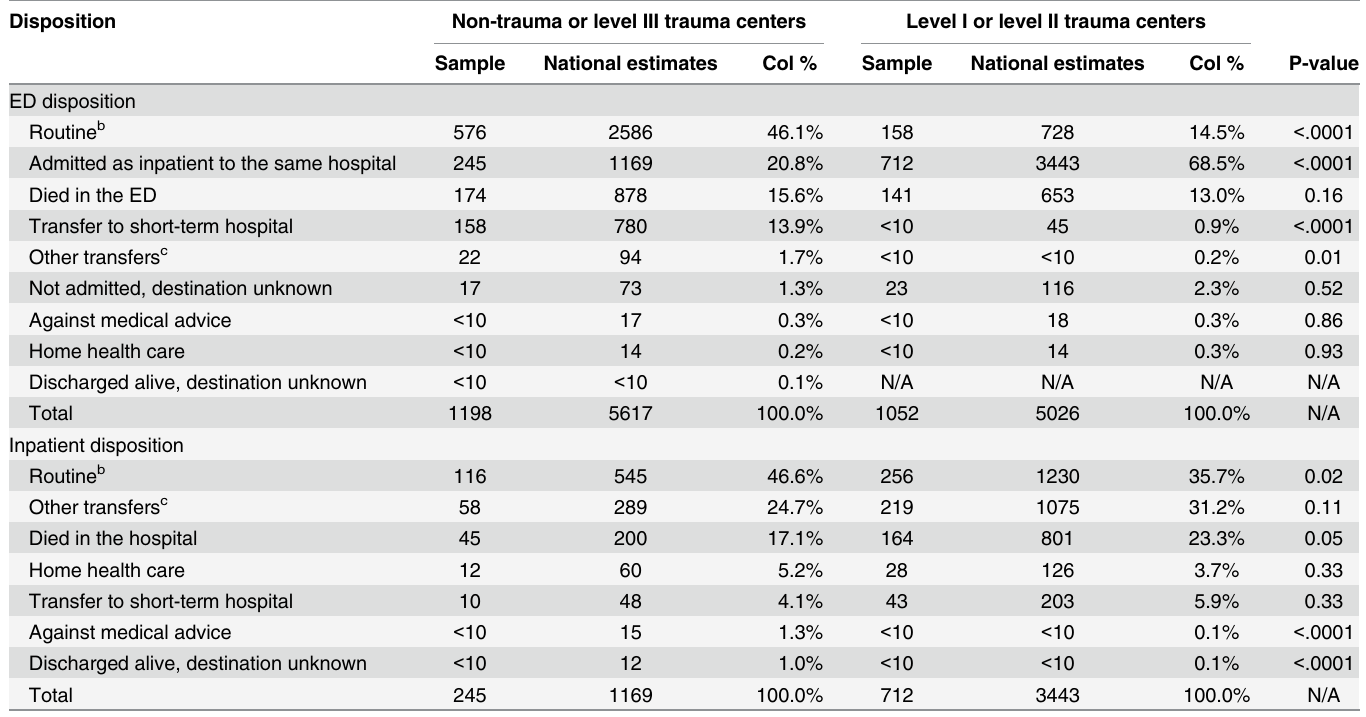
Table 2. Disposition distribution among patients with ISS of 75, NEDS 2006 – 2010 a